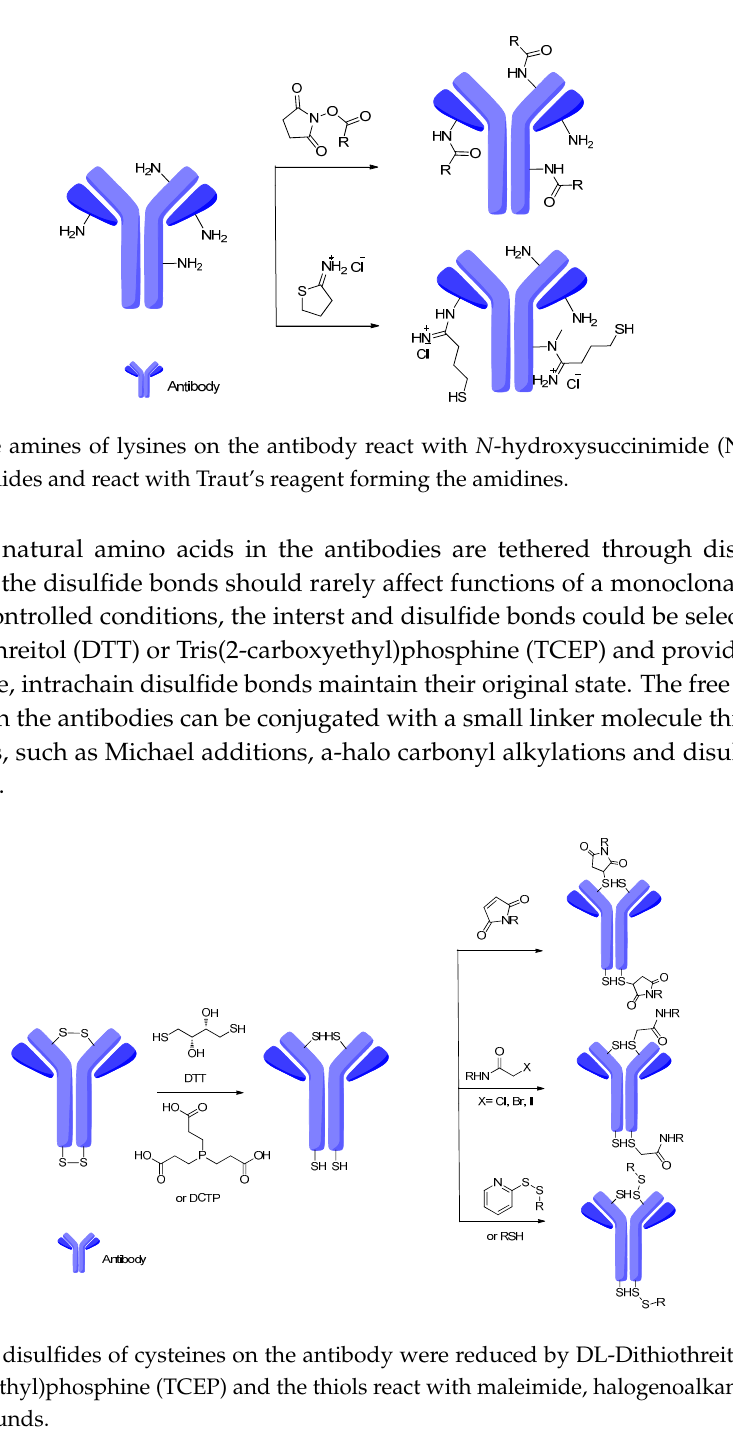
Figure 16. The hydrolysis of the succinimide-thioether ring results in a “ring-opened” linker. Adapted from reference [95]. The attachment sites on the antibodies employing the natural amino acids do not require preliminary modifications and allow for efficient reactions to take place. However, the disadvantages of the non-specific attachment sites could lead to variability and heterogeneity among conjugates. The heterogeneous conjugates containing diverse drugs are difficult to purify and characterize, which might influence ADC PK and stability [98,99]. With the development and requirement of homogeneous ADCs, site-specific antibodies have been obtained via the technology of interchain cysteine cross-linking, besides the recombinant approaches [100]. In recent years, some novel cysteine-reactive functionalities have been developed to yield site-specific antibody fragments or full antibodies via the insertion of specially designed chemical molecules or groups into native disulfide bonds, such as pyridazinedione,